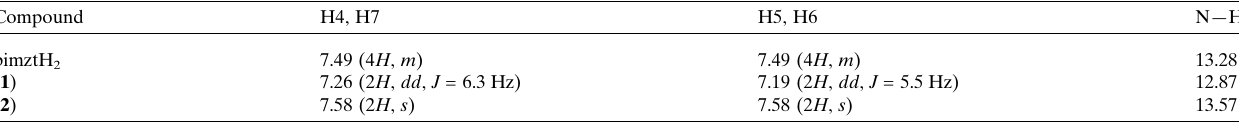
Table 4 1 H NMR chemical shifts (p.p.m.) of the bimztH Compound